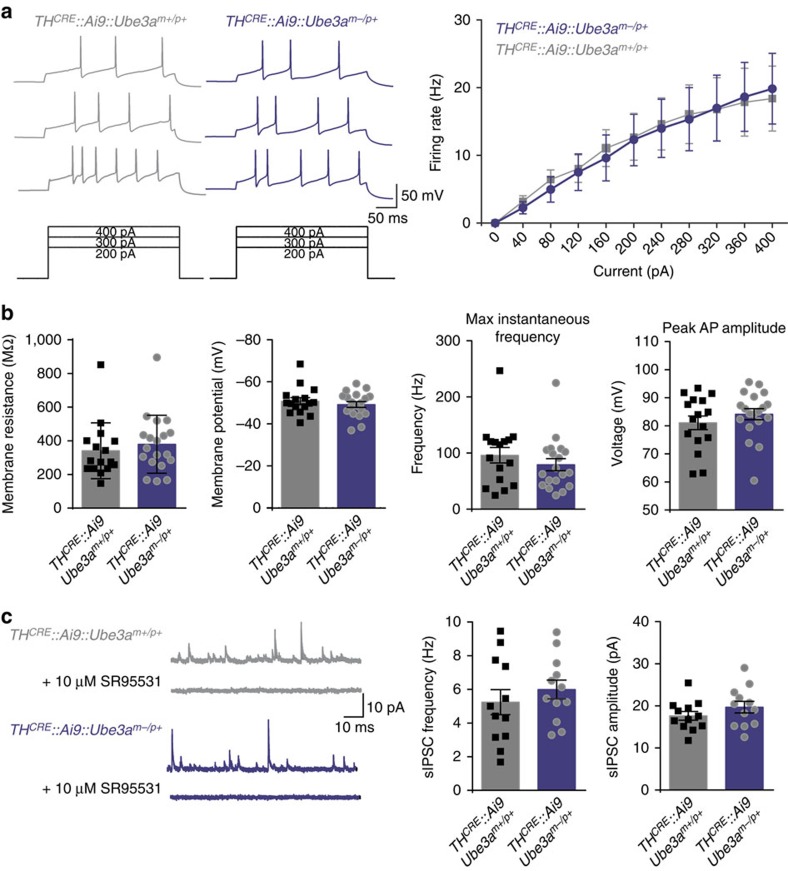
Maternal deletion of Ube3a has no apparent effect on intrinsic excitability and inhibitory input onto VTA neurons.(a) Representative traces and average data showing action potential firing rates to increasing current injections in Ai9-positive VTA neurons in THCRE::Ai9::Ube3am−/p+ and THCRE::Ai9::Ube3am+/p+ mice (n=18 per group, Student's t-test, P=0.70). (b) Average values of resting membrane potential (Student's t-test, P=0.46), membrane resistance (P=0.25), maximum instantaneous firing frequency (Student's t-test, P=0.22), and average action potential peak amplitude (Student's t-test, P=0.32) of Ai9-positive neurons. (c) Representative traces and average data showing the frequency and amplitude of sIPSCs in Ai9-positive neurons (n=12 for each genotype, Student's t-test, P=0.42, P=0.24). GABAergic currents were validated by bath application of SR95531. All bars represent mean±s.e.m.